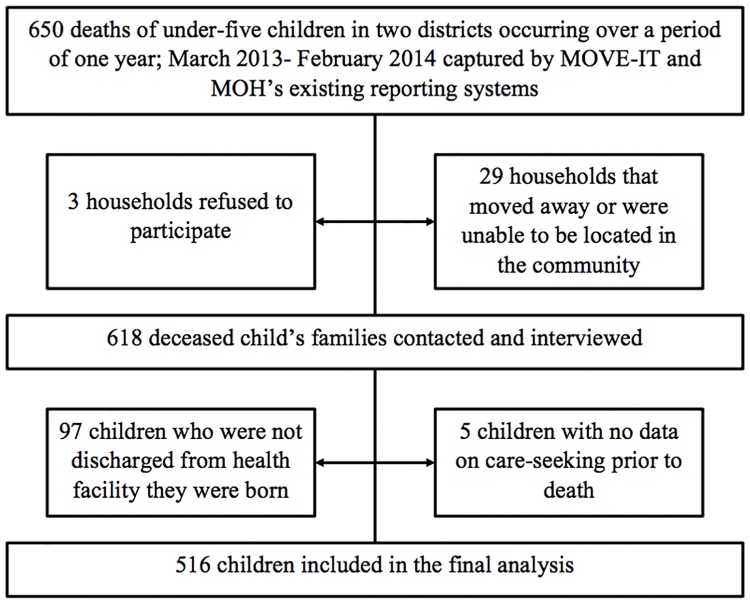
Study participants.